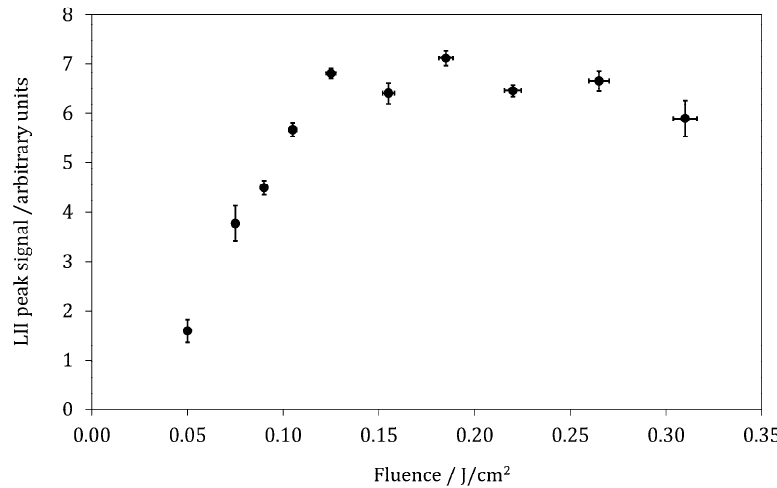
Figure 7. LII peak signal versus fluence curve. The vertical error bars are obtained from the standard deviation of the 1000 LII single-shot images evaluated, while the horizontal error bars are the standard deviation of the laser fluence.